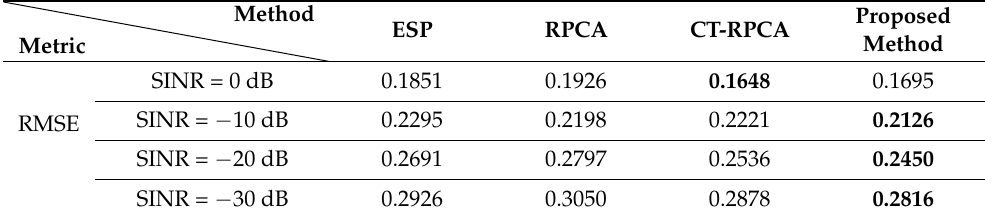
Table 2. Evaluation metrics for the four methods in the different SINR cases.